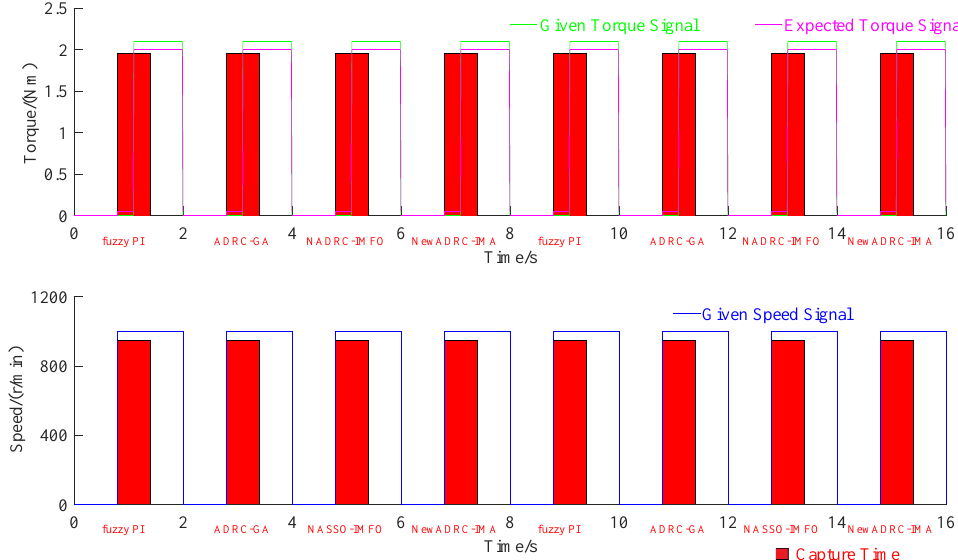
Figure 7. The reference speed and torque signal flow diagram of experiment